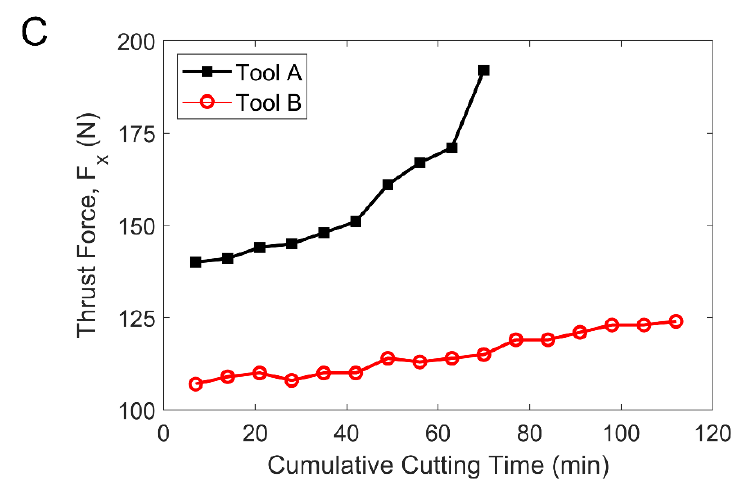
Figure 8. The comparison curves of the cutting forces of Tool A and Tool B over time. ( A ) The main cutting force. ( B ) Feed force. ( C ) Radial thrust force.